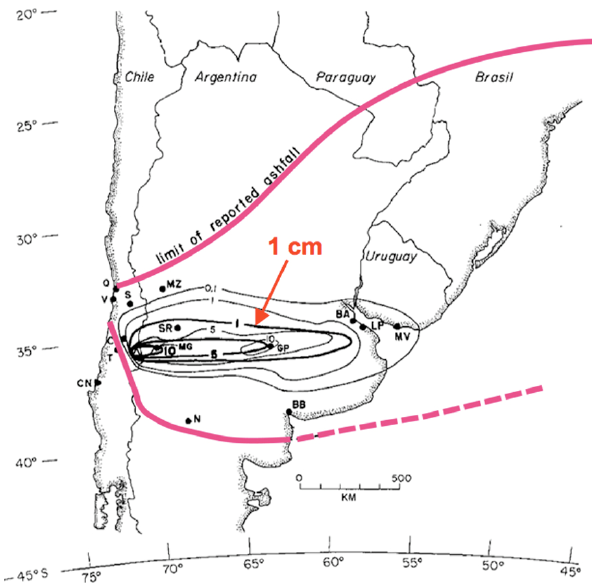
Fig. 7. Isopach map of the ashfall from the 1932 Quizapu (Cerro Azul) eruption, Chile. The thin-line isopachs are for uncompacted ash (from Larsson, 1937), and the heavy-line isopachs are those measured by Hildreth and Drake (1992) during 1980–1991. The limit of reported ashfall is indicated by heavy red line, and the 1cm isopach by the red arrow (from Hildreth and Drake, 1992, Fig. 1).